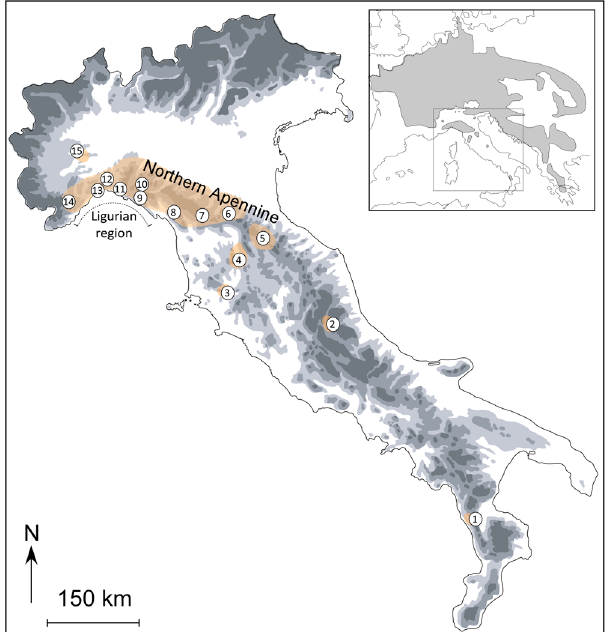
Figure 1. Geographical distribution of Ichthyosaura alpestris on the Apennine peninsula and the geographical locations of the 15 populations sampled. The locations are numbered as in Table 1. The inset shows the distribution of I . alpestris within the Western Palearctic region. The map was drawn using the software Canvas 11 (ACD Systems of America, Inc.).